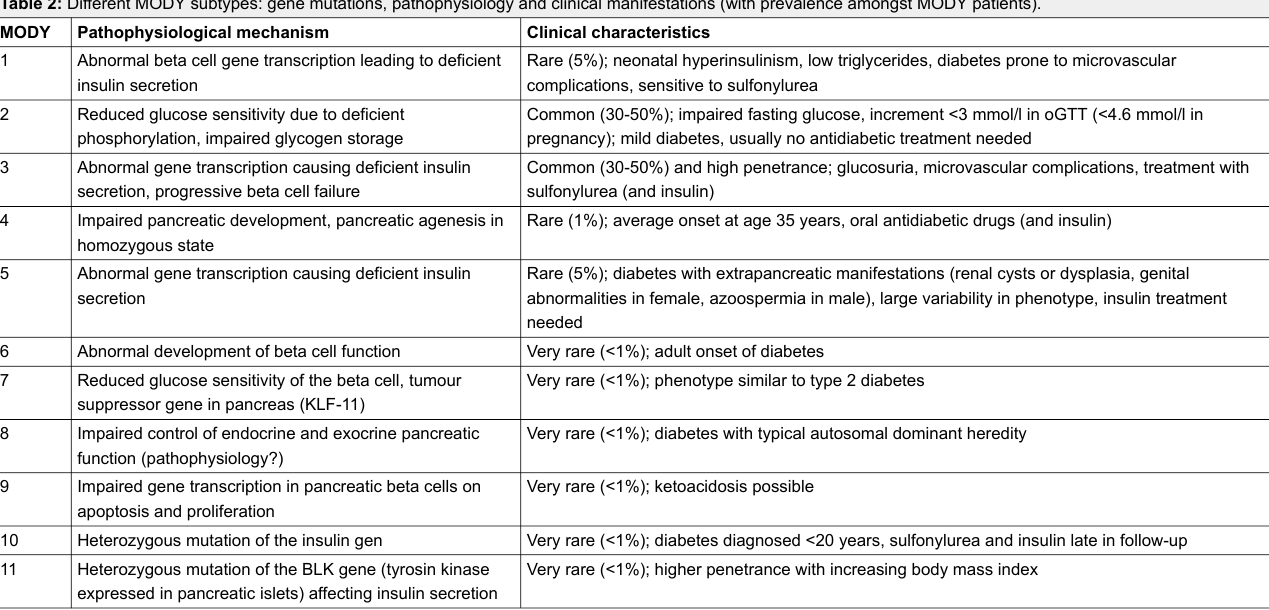
Table 2: Different MODY subtypes: gene mutations, pathophysiology and clinical manifestations (with prevalence amongst MODY patients). MODY Pathophysiological mechanism Clinical